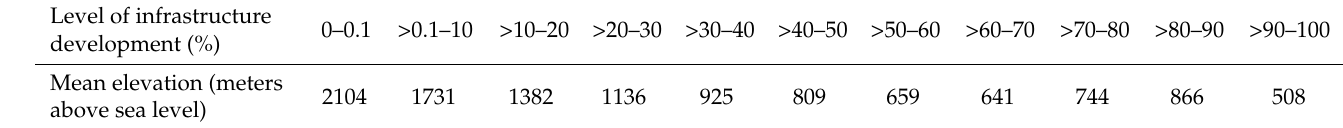
Table 3. Calculation of mean elevation values for zones of different infrastructure development levels within the Alpine Convention perimeter (source: own compilation, numbers rounded).